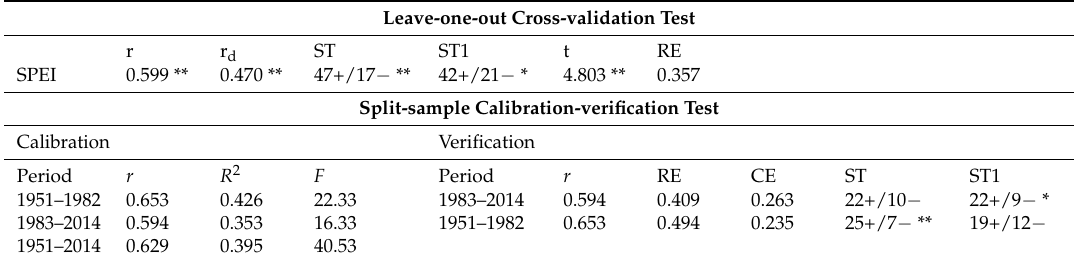
Table 1. Statistics of the leave-one-out cross-validation and the split-sample calibration-verification test model for the SPEI